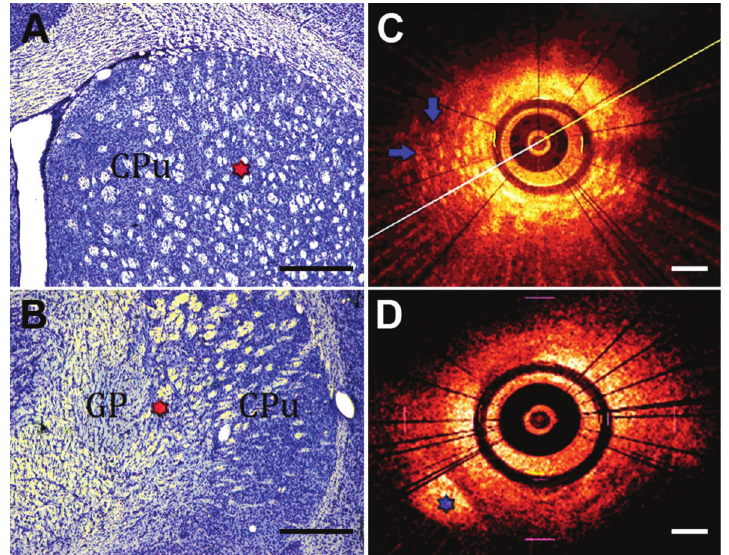
Figure 1. Histological and optical coherence tomography (OCT) images of CPu [caudate- putamen (striatum)] and GP (globus pallidus). A , B , coronal sections of rat brain striatum and their corresponding in vivo images on the right side ( C , D ). OCT images identi fi ed tissue types based on the interface between the gray basal nuclei and white matter. Red stars in A and B indicate chosen target; in C, the blue arrows point out a striosome pattern; in D , the blue star indicates the GP, which corresponds to the target on the red star ( B ). The scale bar corresponds to 200 m